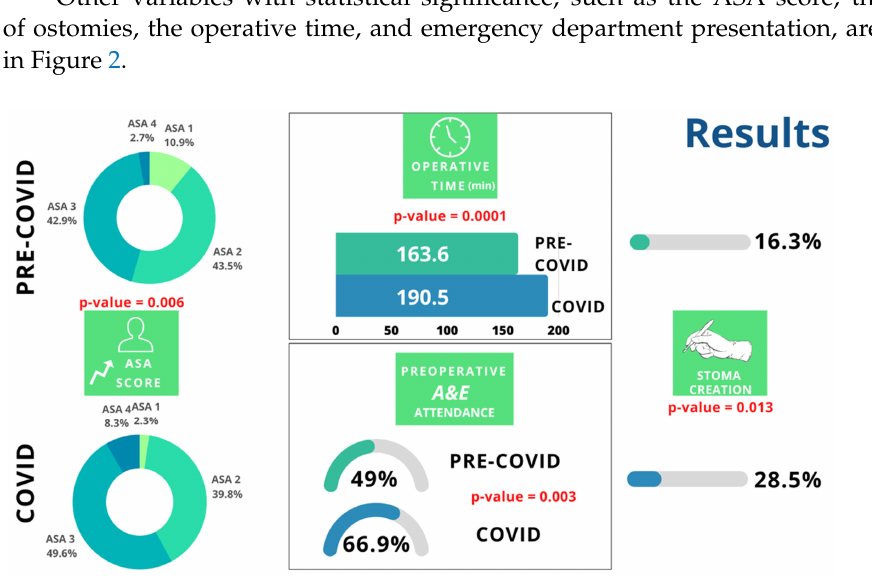
Figure 2. Analysis of statistically significant variables. The COVID-19 pandemic demonstrated the fragility of oncologic surgery setups worldwide. An international study by Glasbey et al., spanning 20,006 solid organ cancer patients across 61 countries showed that, in regions with full lockdowns, one in seven patients did not undergo planned surgery and experienced longer preoperative waiting times. Findings such as an increase in the positive resection margins or new metastatic disease due to the delays in the treatments highlight compromising short and middle term outcomes; furthermore, delays and missing operations certainly might affect long-term outcomes including disease-free survival [23,24]. There are little data regarding the clinical presentation and surgical outcomes of CRC during the pandemic. The present study focuses on CRC patients undergoing surgery in the period that goes from March 2020 to February 2022, when the government activated different levels of the public health emergency response. The principal aim was to investigate the impact of the pandemic on the diagnosis, treatment, and short-term outcome of CRC patients undergoing surgical resection. As part of the strategy of prevention, with the exception of the first three months of the pandemic, in which most of the services were shut and only the emergencies were taken care of, in-hospital routine medical services were continuously adjusted based on the changes and requirements for the prevention and control of the pandemic. Most of the benign pathology commonly treated in colorectal units were discontinued [25–27]. Nevertheless, even during the lockdown, oncology patients were assured priority for receiving a standard of care treatments. Thanks to team efforts, oncological units were capable to keep the latency between CRC diagnosis and treatment below the 6-week range, as required by ESMO guidelines [28]. As such, we reported the same experience by not prolonging the interval between diagnosis and surgery for the time period analyzed over a mean time of 15 days. However, several reports, from Spain, Japan, and other countries [29–32] described a generalized increase in stage III and IV tumors during the pandemic. We could not find any differences in stage at presentation nor in histopathological data between groups (Tables 2–4), but the subgroup analysis showed, only for left colon tumors, an increase of almost double for stage II cancers and a drop in stage I. This is possibly explained by the